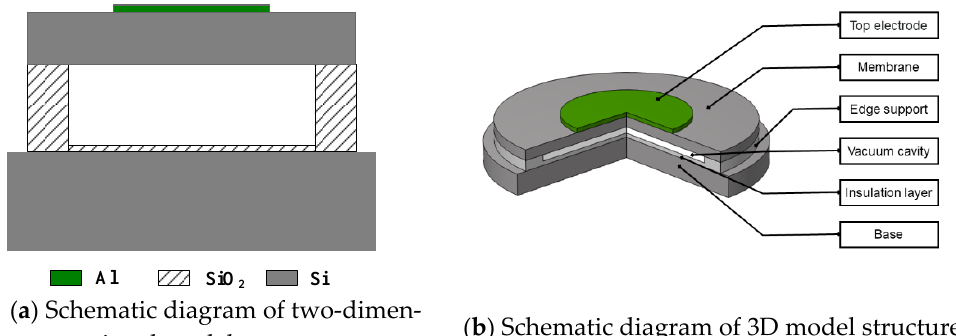
Figure 1. Vacuum CMUT cell structure diagram.